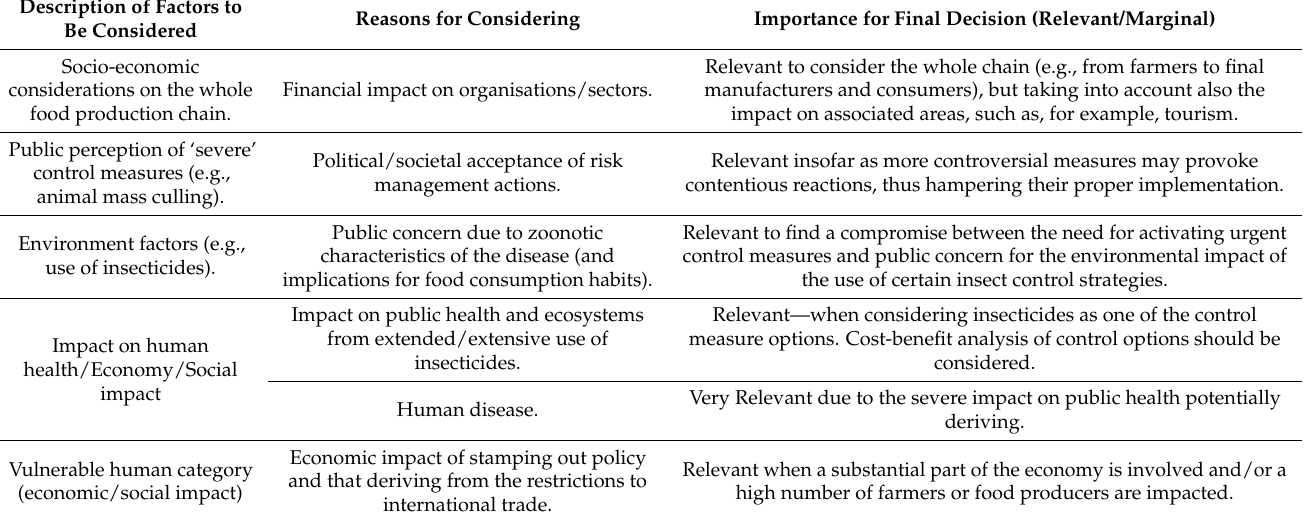
Table 2. Summary of participants’ responses to the question: ‘Which other factors should guide the decision of Animal Health authorities, in addition to the outcomes of the EFSA risk assessment?’ Description of Factors to Reasons for Considering Importance for Final Decision (Relevant/Marginal) Be Considered